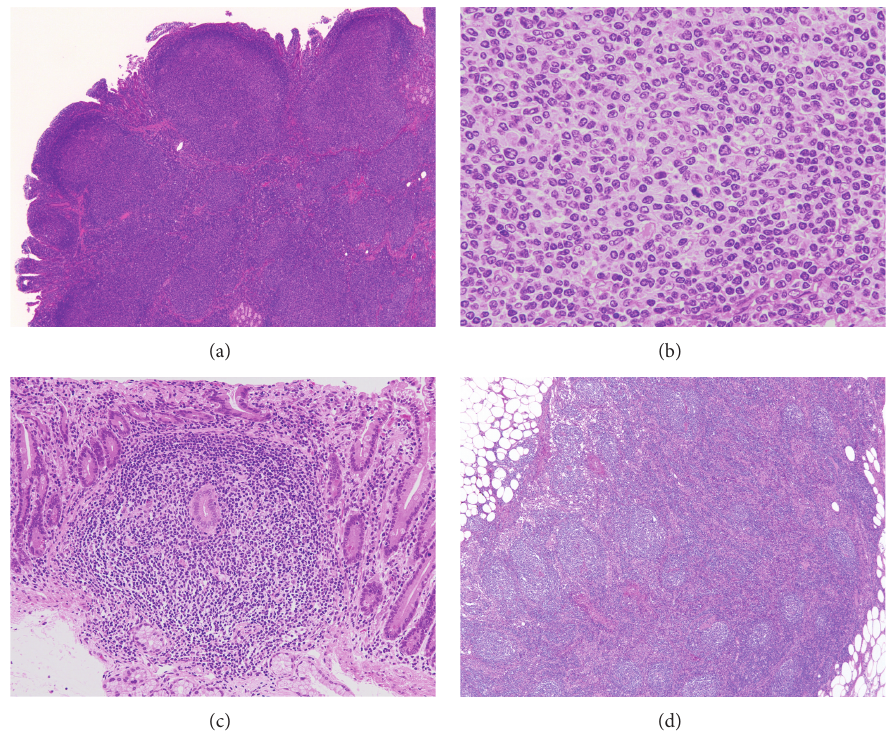
Figure 5: Representative histologic images of the follicular lymphoma. ((a)–(d)) The lesion reveals lymphoid follicular formations (a) with small-to-medium-sized centrocyte-like cells and a few centroblast-like cells (b). Small nodular lesions around the main tumor also consist of follicular lymphoma (c). Regional lymph nodes are partially involved by follicular lymphoma (d).